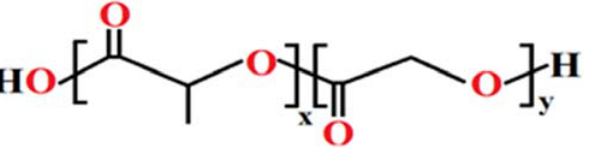
Figure 3. Chemical structure of poly (lactic ‐ co ‐ glycolic acid), where x represents the number of lactic acid units, and y represents the number of glycolic acid units.